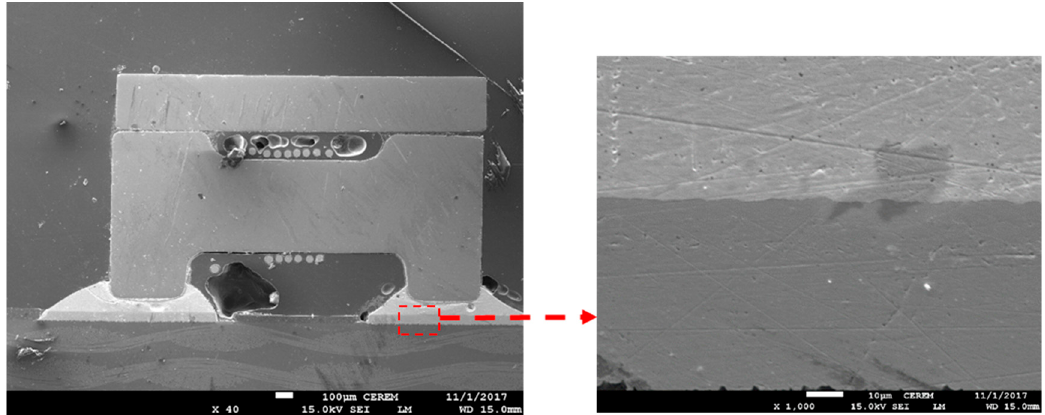
Figure 4. SEM micrograph for the joint interface of a passive component with SAC solder paste.